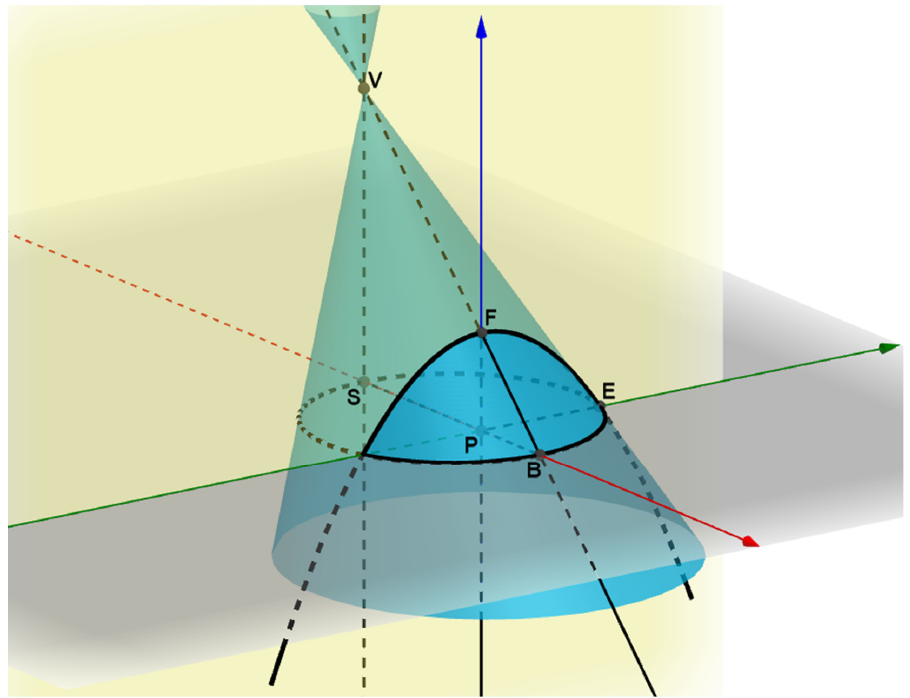
Figure 9. Final stage of Wallis’ construction, in which the cone that has the given parabola as a section is